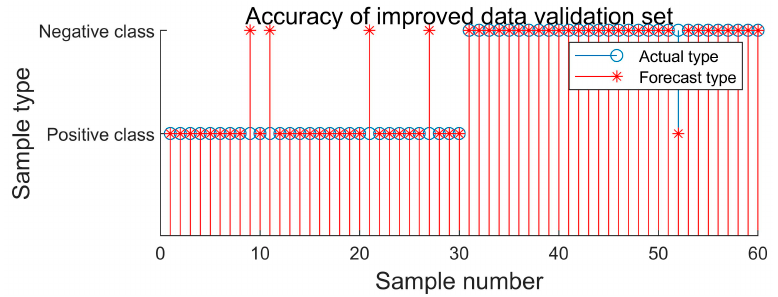
Figure 6. Echocardiogram raw dataset validation accuracy.